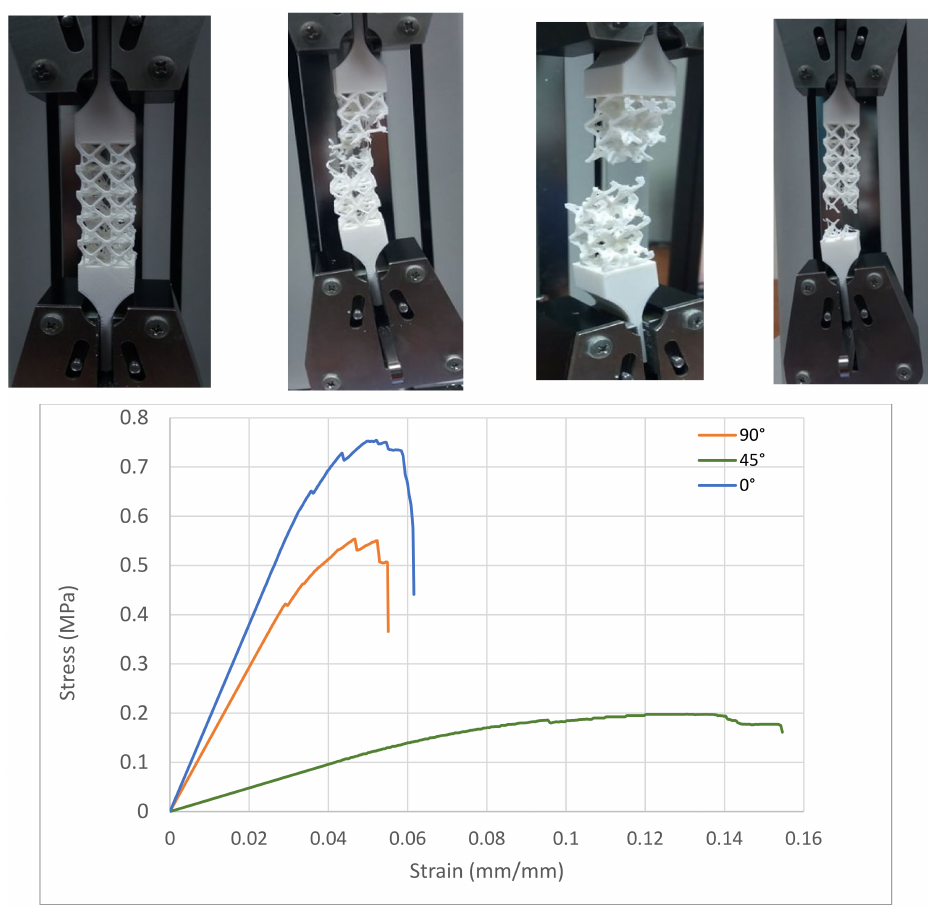
Figure 21. Samples behavior on the tensile strength test, and stress/strain curve of lattice structure #2 for 0 ◦ , 45 ◦ and 90 ◦